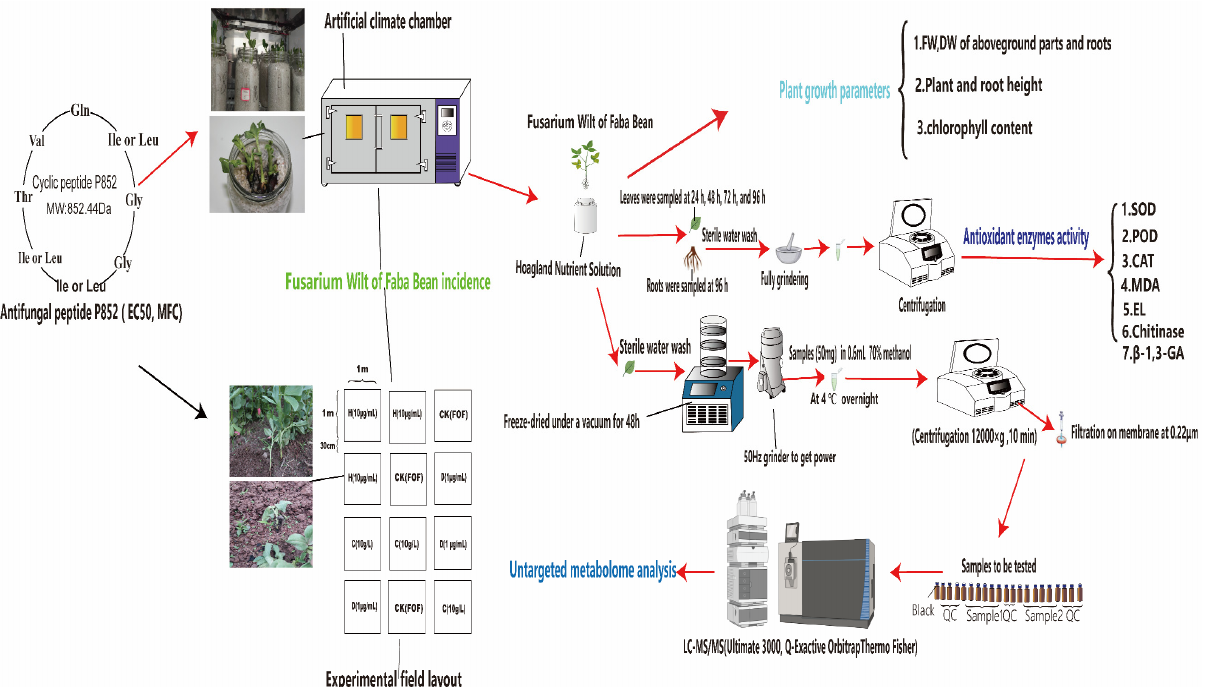
Figure 1. Flow chart for determining Fusarium wilt incidence assessment, plant growth indicators, antioxidant enzyme activity, and nontargeted metabolomics of Faba bean.